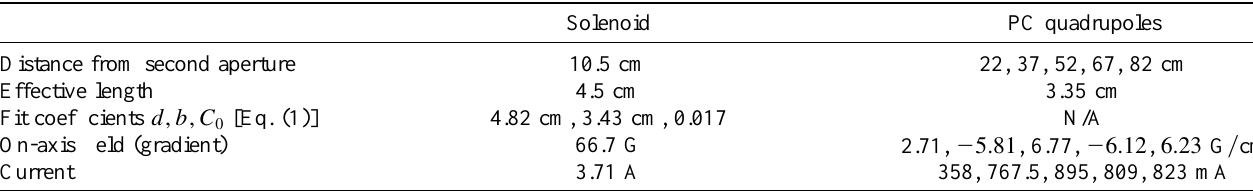
TABLE II. Parameters of focusing elements.